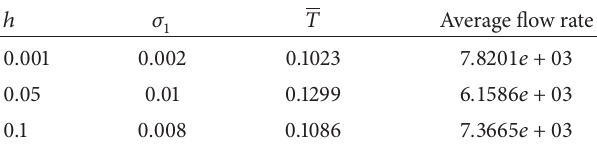
Table 2: Comparison with constant sampling.